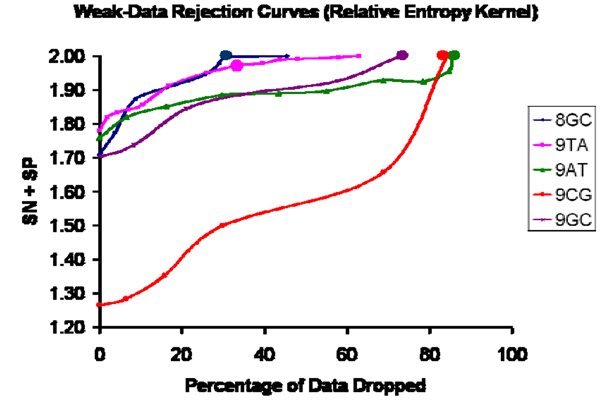
The Percentage Data Rejection vs SN+SP curves are shown for test data classification runs with a binary classifier with one molecule (the positive, given by label) versus the rest (the negative). Since the signal calling wasn't passed through a Decision Tree, it doesn't accurately reflect total throughput, and they don't benefit from the "shielding" shown in the Decision Tree in Fig. 1 prototype. The Relative Entropy Kernel is shown because it provided the best results (over Gaussian and Absdiff).